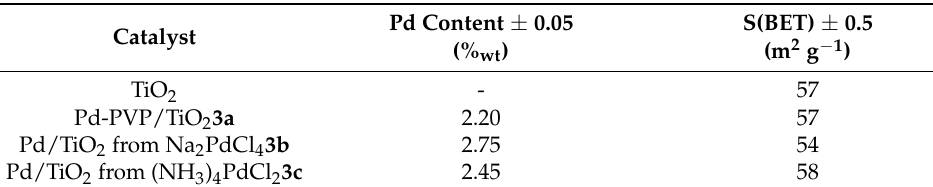
Table 1. Characteristics of materials of Family 3 .